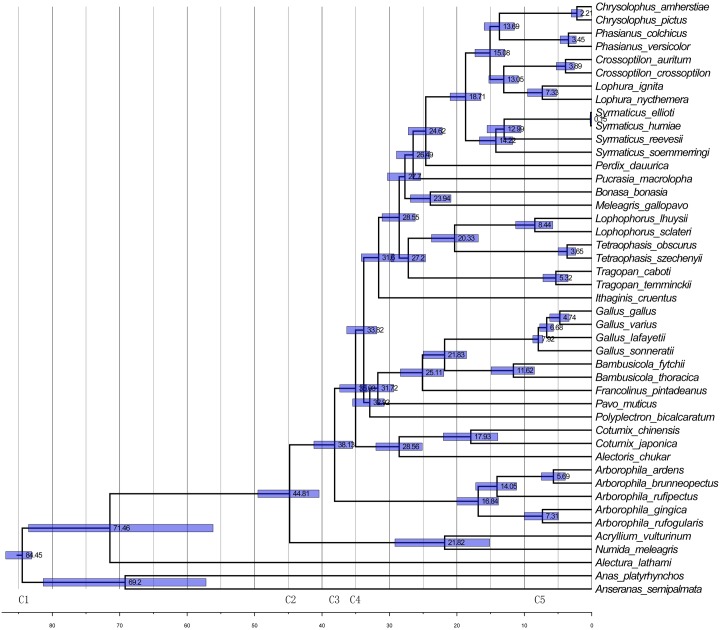
Species tree with estimated divergence time.The divergence times were estimated in BEAST with five fossil calibrations (C1-C5). Mean ages are included beside corresponding nodes. Horizontal gray bars on each node indicate the 95% credible interval of divergence time in millions of years, with the unit of divergence time as Mya.